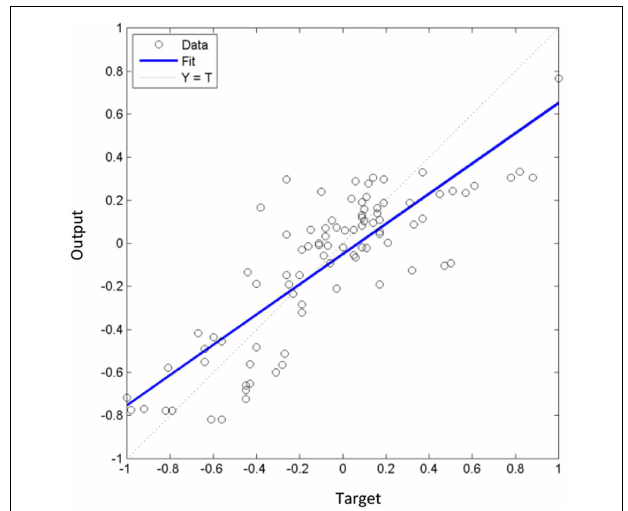
FIGURE 8 | Cross-validation result of the best fit obtained in the Simulation 2 with MSE = 0.05 and corr = 0.83. The output simulated using as target the observed daily precipitation during FMA season and input the simulations of this variable from the four CMIP5 models in analysis during DJF season of 1963–2003 period over the north of the NEB is: Output = 0.7 * target + −